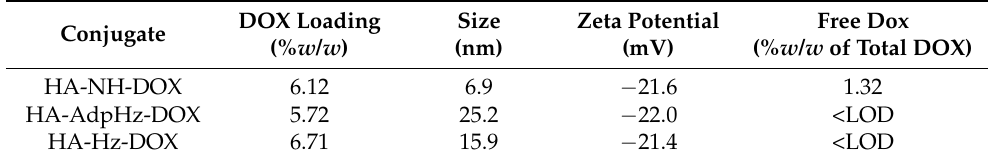
Table 1. Characterization of HA-DOX conjugates. Conjugate